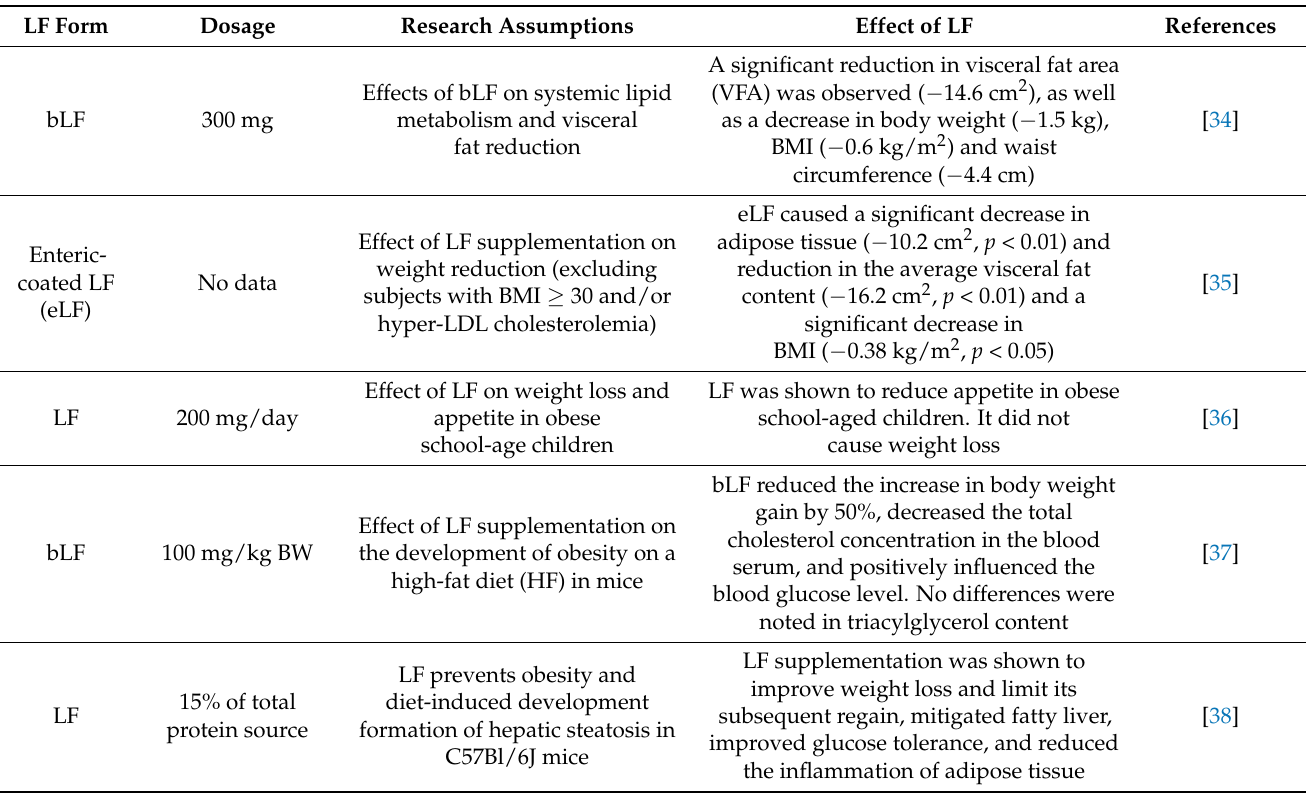
Table 1. Use of LF supplementation in obesity (own